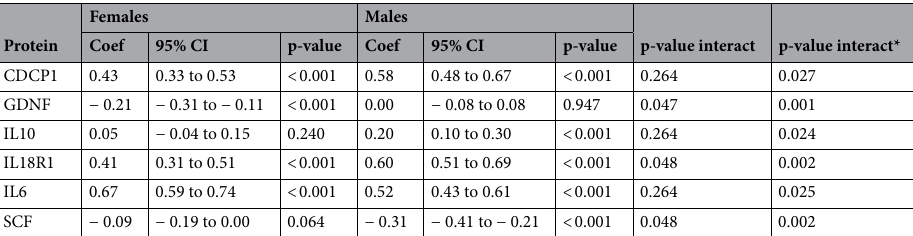
Table 2. Association between %BF and protein levels in females and males for proteins with effect modification by sex. Stratified analyses in men and women from linear regression of transformed protein levels adjusted for smoking, e-cigarette use, snuff use, and age at follow-up. The table includes all proteins with unadjusted p-value for the interaction term %BF#Sex of < 0.05. p-values at 0.05 FDR. *p-value for the interaction term without FDR